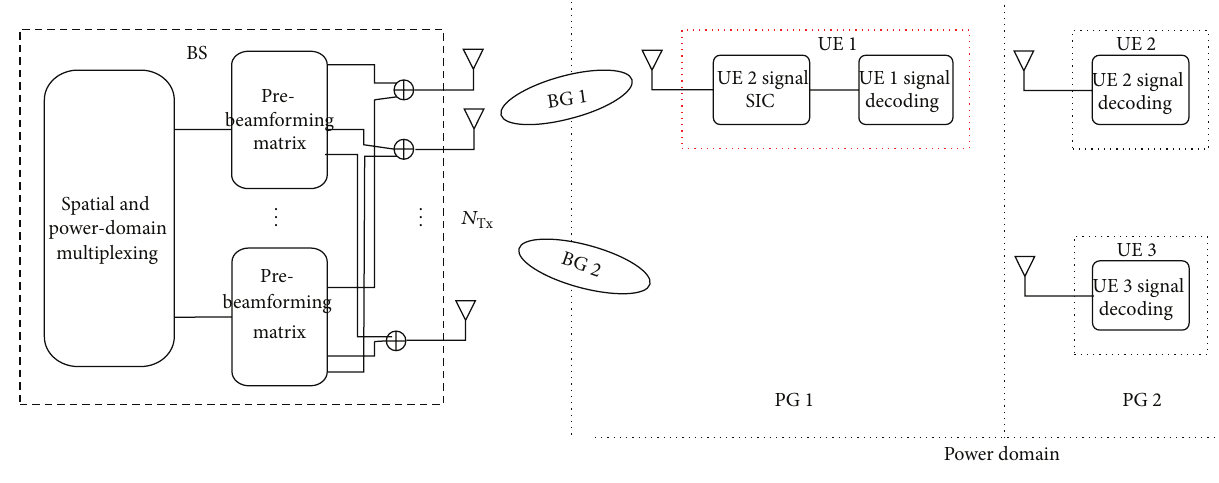
Figure 2: Power-domain multiplexing BS-UE transceiver diagram.